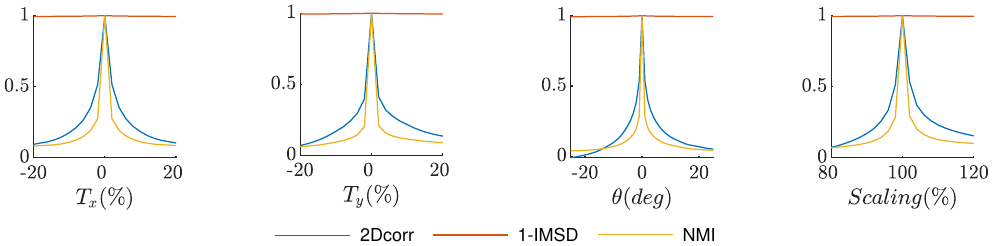
Figure 8. Metric response to independent camera movement components under idealized conditions, i.e., when each video frame is compared to the stable version of itself. Averaged values along all studied video sequences. Camera movement components are: translation in X direction ( T x ), translation in Y direction ( T y ), rotation ( θ ) and scaling. 1-IMSD is displayed for consistency with the rest of metrics.